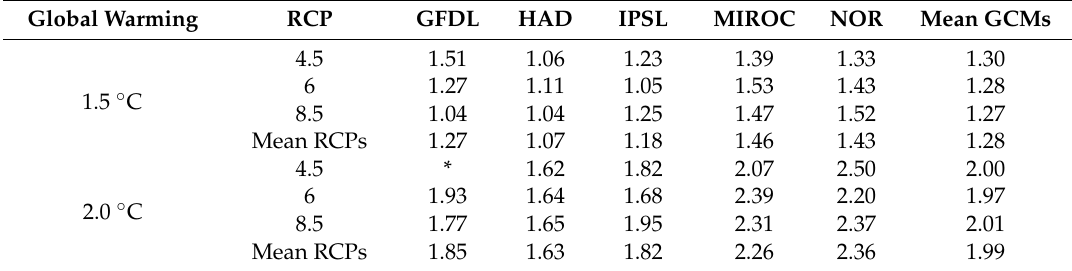
Table 3. Changes in annual mean temperature in CRB under the 1.5 °C and 2.0 °C global warming (°C). Global Warming RCP GFDL HAD IPSL MIROC